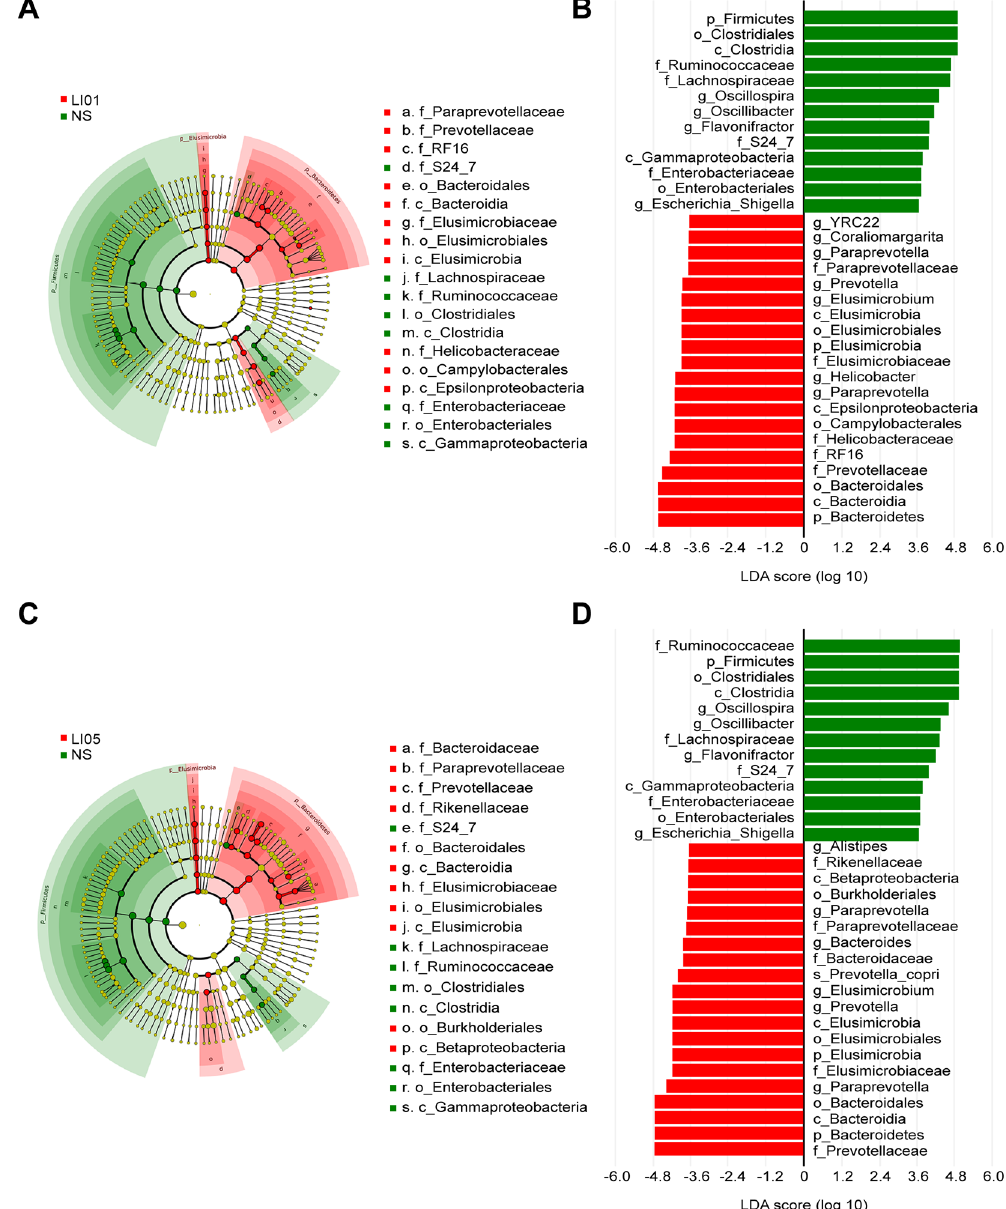
LI05 group compared to the NS group. ( A , C ) The cladogram shows the phylogenetic relationship between the microbial taxa that were higher in probiotic samples compared to those in the cirrhotic rats in the NS group. ( B , D ) LDA scores showed significant bacterial differences between the NS and probiotic groups. Only the taxa meeting a significant LDA threshold value of > 3.6 are shown. Red indicates the LI01 or LI05 group, and green indicates the NS